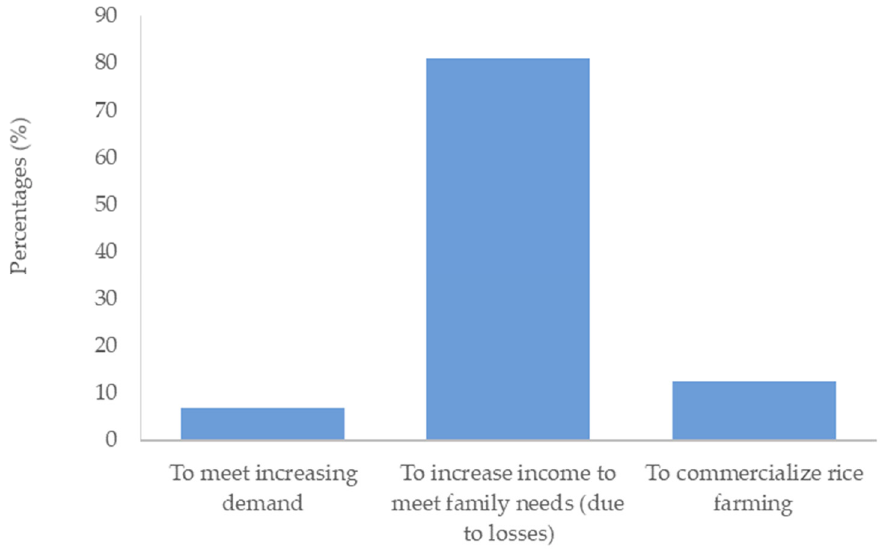
Figure 4. Farmers’ reasons for increasing swampy wetland use.